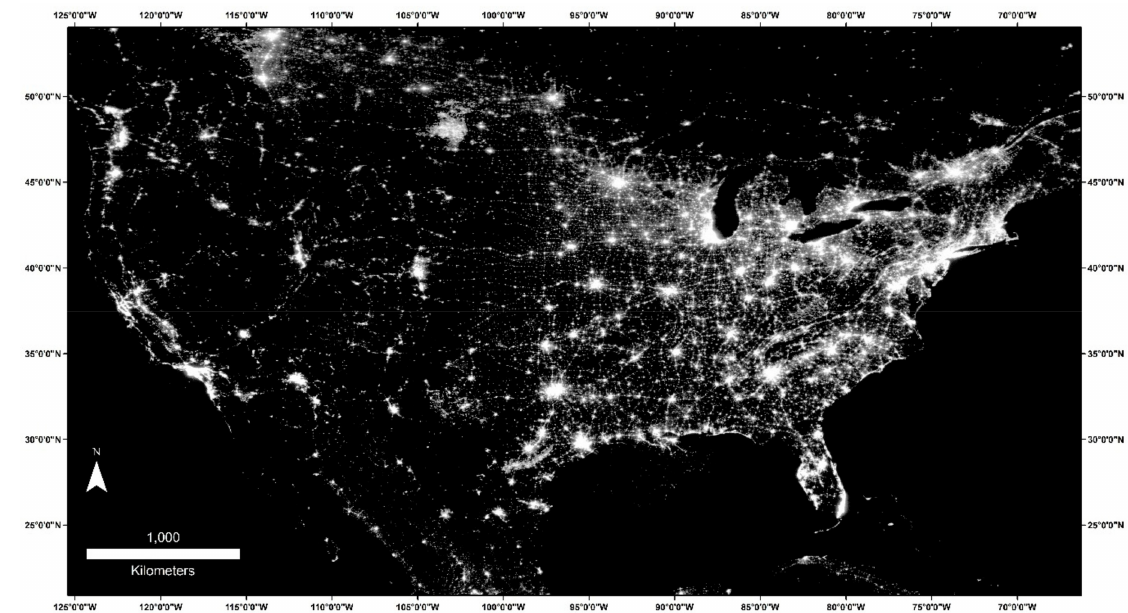
Figure 1. Night lights according to the DMSP stable lights annual composite, 2013.